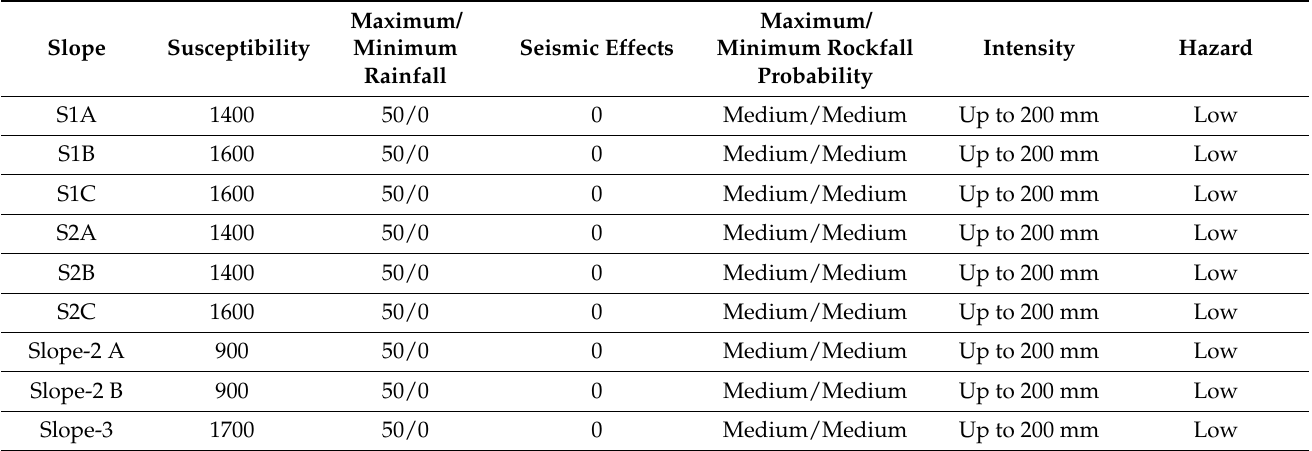
Table 11. Rockfall susceptibility, probability and hazard of each slope according to the Bauer & Neumann [8] original method.